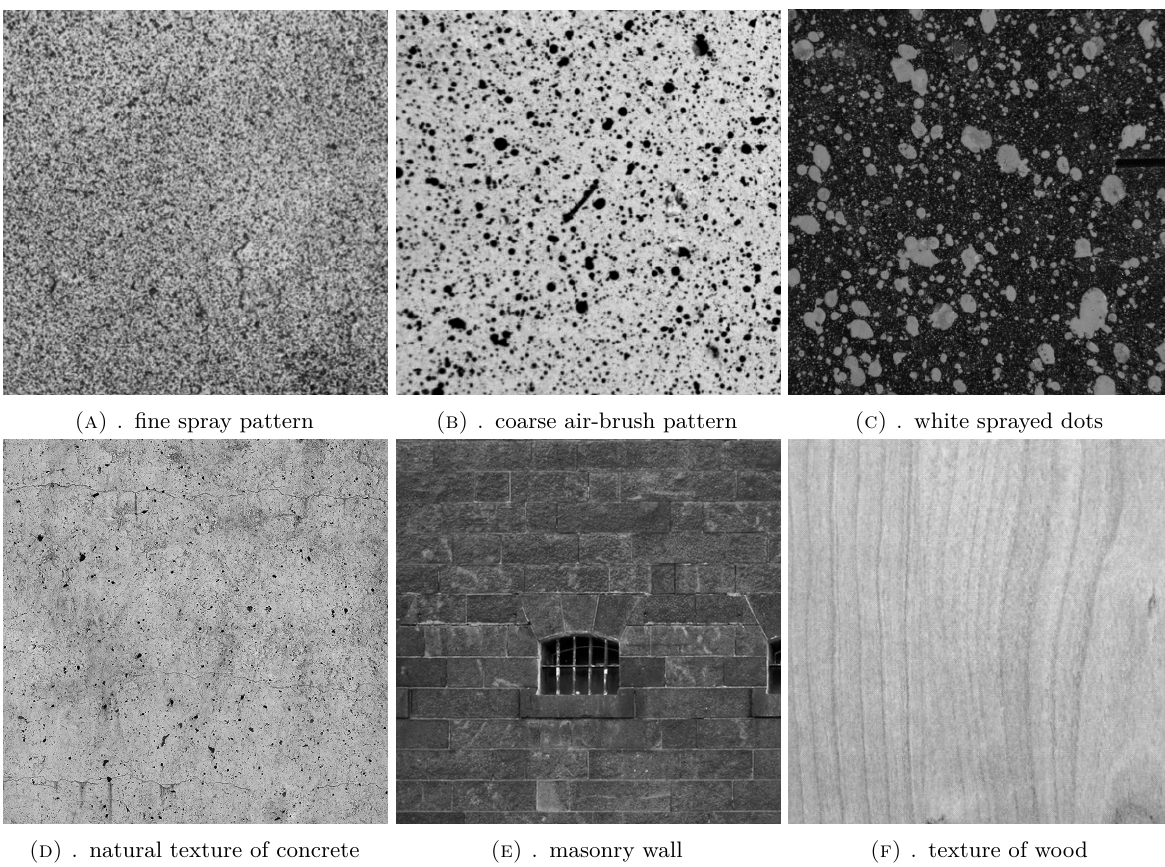
Figure 2. Investigated artificial patterns (top) and natural textures